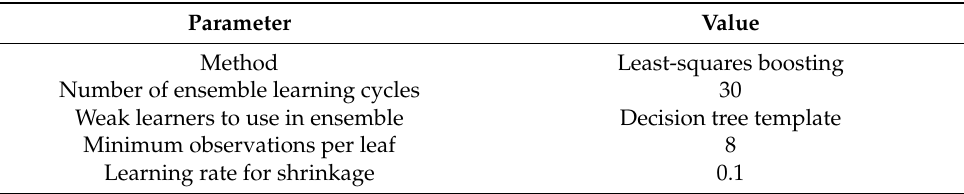
Table 4. Hyperparameters used for training of “Fit ensemble of learners for regression” in